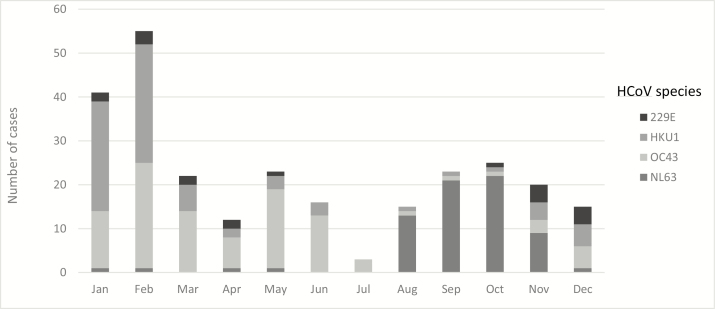
Number of human coronavirus (HCoV) cases over the study period, by HCoV species. Seasons are as follows: summer–monsoon, June–August; autumn, September–November; winter, December–February; spring, March–May.